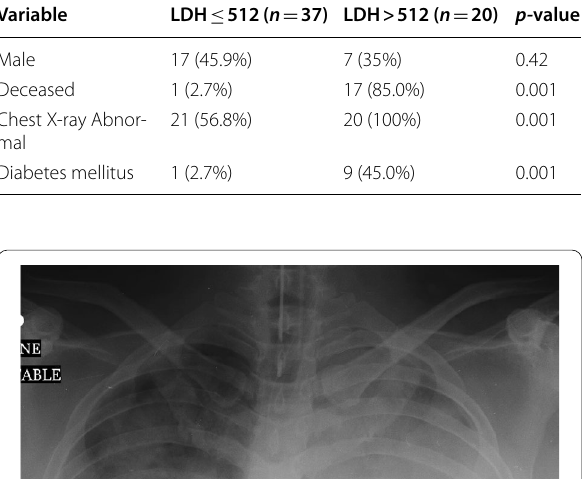
Table 2 Association of demographic and clinical characteristics according LDH in 57 MERS-Cov patients Variable